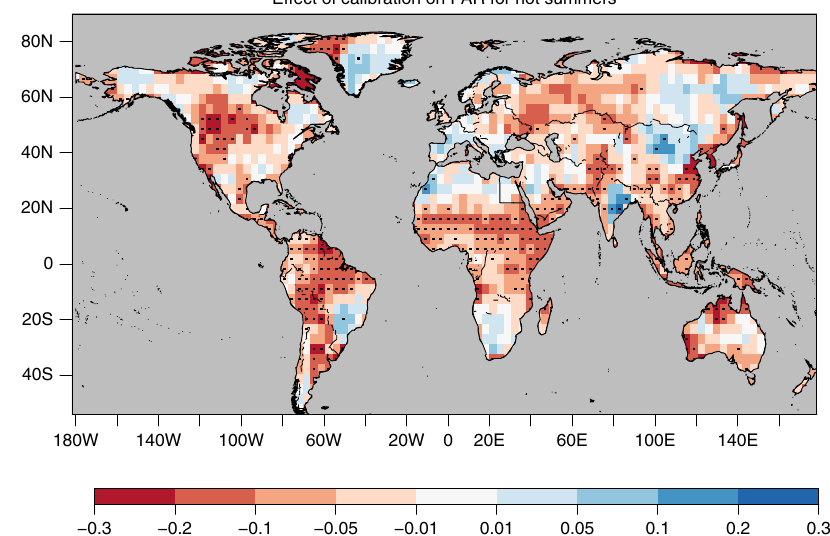
Fig. 3 Effect of the model ensemble calibration on the fraction of attributable risk (FAR) to anthropogenic forcings of boreal hot summers. The change denotes the FAR calculated after the calibration minus the FAR calculated from the raw HadGEM3-A, as illustrated in Fig. 1 but on a global scale. The model probabilities are estimated by fi tting a Normal distribution to all ensemble members. Stippling denotes a signi fi cant change in FAR determined by resampling at a 10% signi fi cance